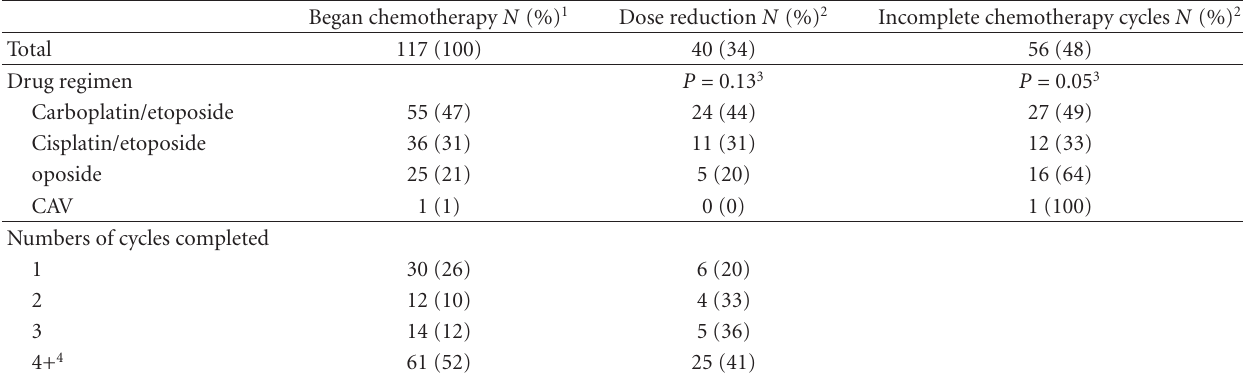
1 Column percentage. 2 Row percentage: denominator is the number who began chemotherapy in corresponding row. 3 P values based on Fisher’s exact test. 4 Defined as completed chemotherapy